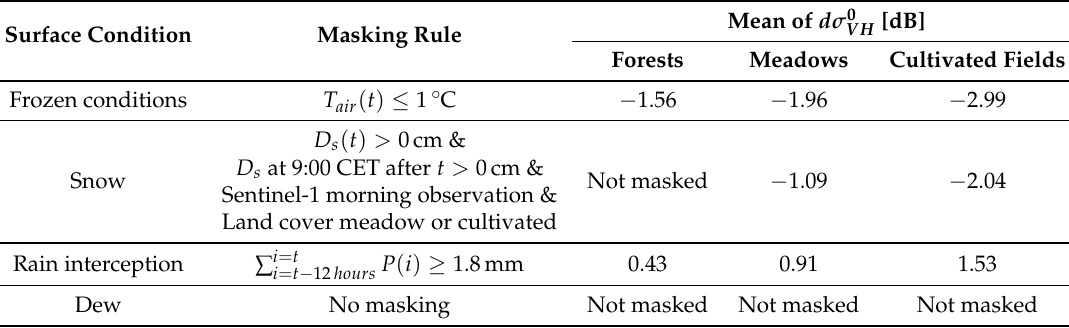
Table 5. Same as Table 4, for the Sentinel-1 VH